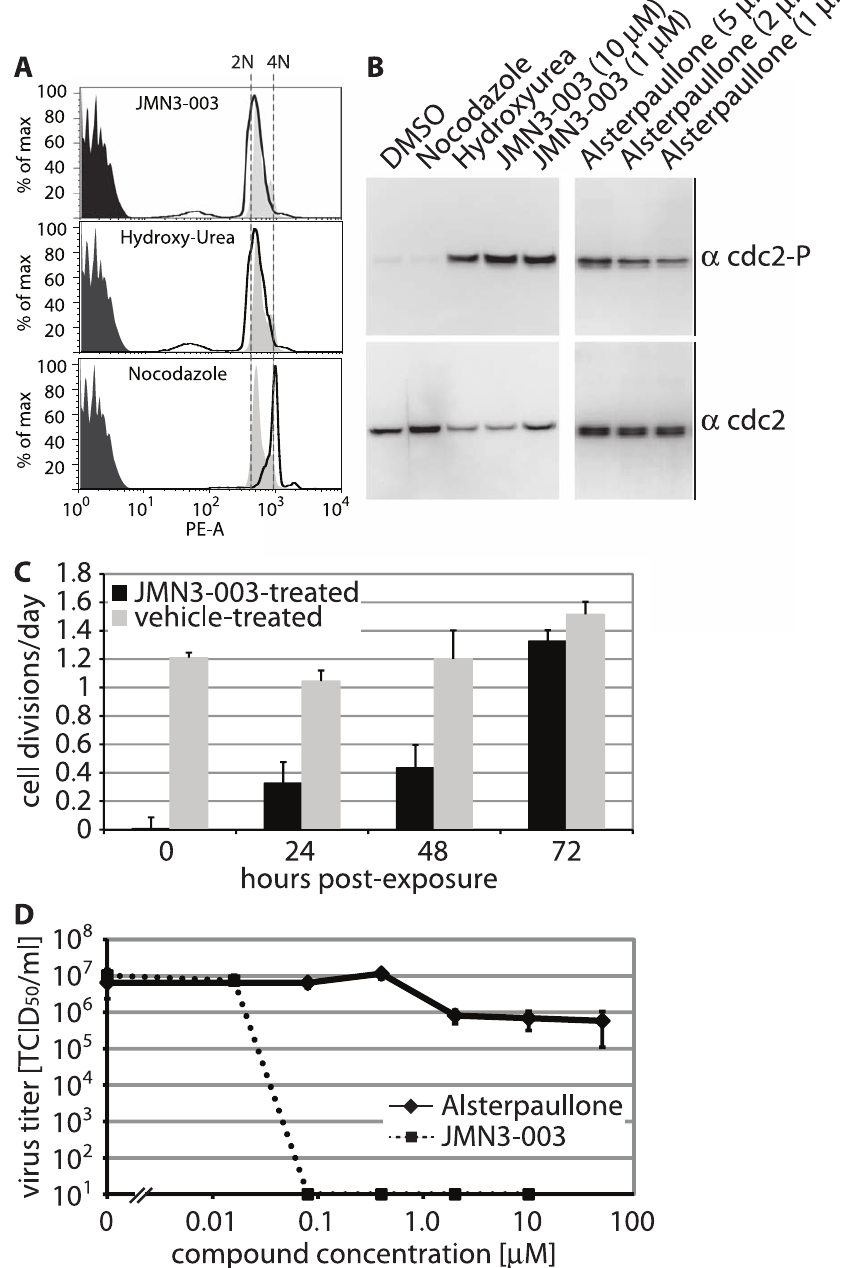
Figure 4. Cell exposure to compound JMN3-003 induces a temporary G 1 /S phase cell cycle arrest. A ) FACS analysis of acridine orange- stained HeLa cells incubated in the presence of JMN3-003 or hydroxyurea for 36 hours, or nocodazole for 16 hours. Dark grey shaded areas show unstained cells, light grey areas correspond to vehicle-treated control cells, and areas under open black curves represent treated cell populations. Dashed vertical lines indicate 2 N (G 1 /S) and 4N (G 2 /M) DNA contents. Data shown are representative of three experiments and reflect 10,000 events/ condition of treatment. B ) Analysis of the phosphorylation status of cdc2-cyclin B kinase after cell exposure to JMN3-003 through immunoblotting using specific antisera directed against phospho-cdc2 (Tyr15; a cdc2-P) or total cdc2 ( a cdc2) for comparison. For control, cells were treated with nocodazole, hydroxyurea, or alsterpaullone (right panel). Results shown are representative of multiple experiments. C ) Wash-out of JMN3-003 restores cell proliferation. Growth rates of Vero cells were determined after 30-hour exposure of cells to JMN3-003 or vehicle only, followed by wash- out of the substance. Values reflect cell divisions per day and are based on averages of six independent replicate experiments 6 SEM. D ) G 1 /S phase cell cycle arrest does not affect MeV proliferation per se . Dose-response curves for alsterpaullone, a nanomolar CDK1/cyclin B kinase inhibitor, and MeV-Alaska grown on Vero-Slam cell. Titers of cell-associated viral particles were determined 36 hours post-infection through TCID 50 titration. JMN3- 003 was examined in parallel for comparison. Values reflect averages of three replicates 6 SD.